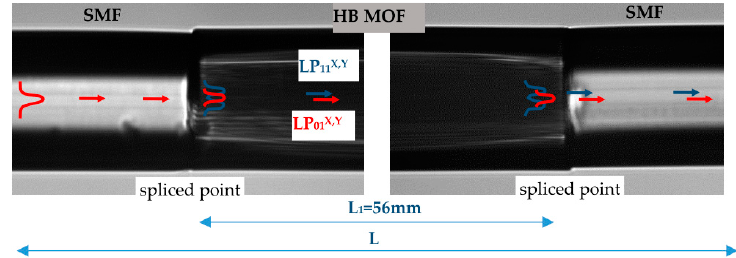
Figure 2. Microscope image and schematic modes distribution in the proposed in-line interferometric sensor composed of 56 mm of HB MOF spliced with leading-in SMF-28 fibers.